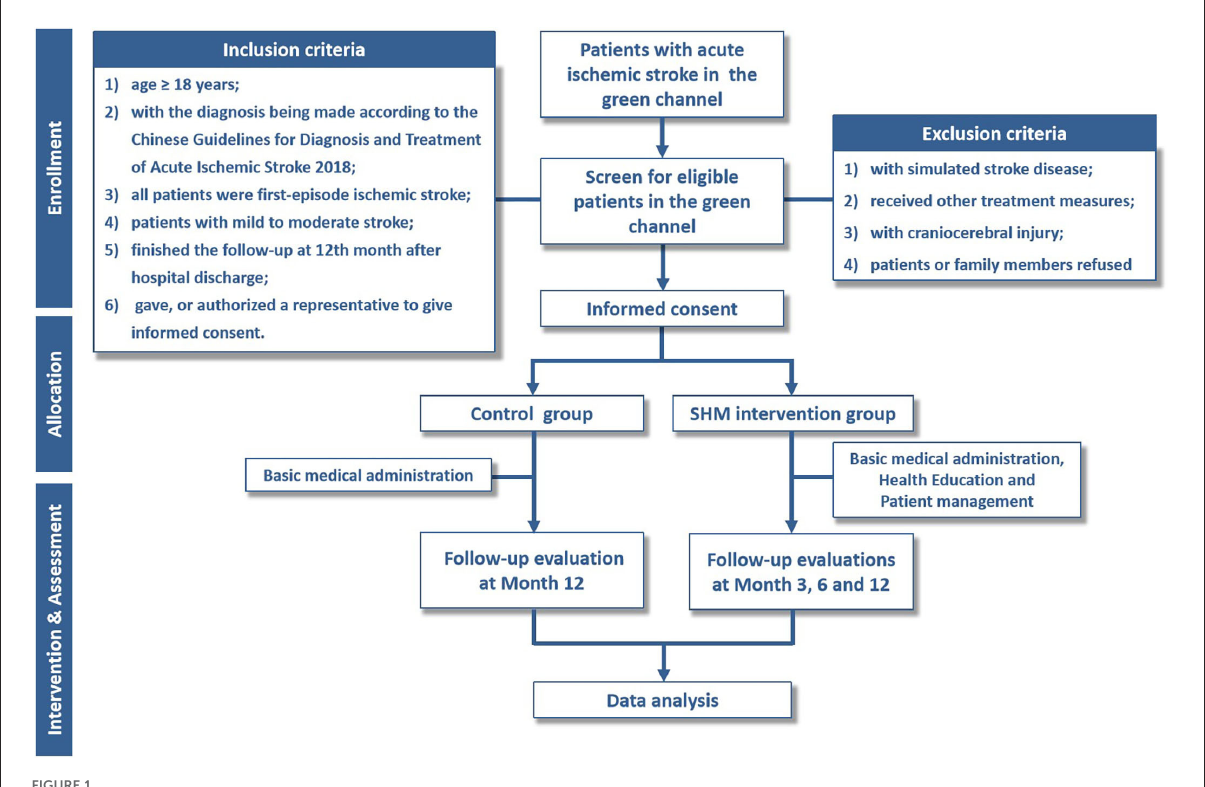
FIGURE1 Flowchart of the trial. SHM, stroke health